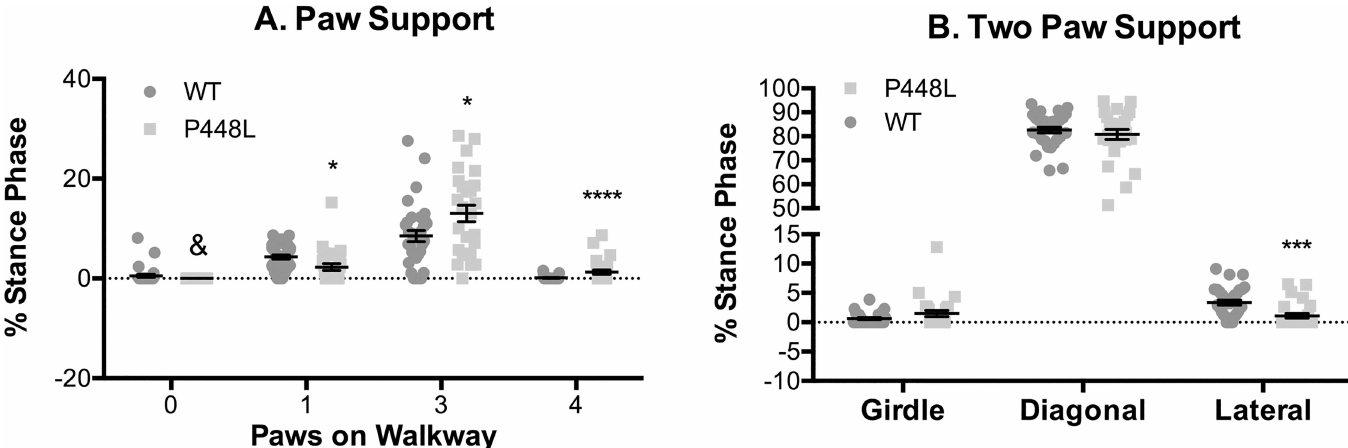
Fig 7. Paw Support. (A) Percentage of rundurationthat no paws, a single paw, threepaws or four paws were simultaneously touchingthe surface. (B) Percentage of rundurationthat two diagonalpaws (RF-LHor LF-RH), contralateral paws (girdle,RF-LFor RH-LH)or lateralpaws (RF-RHor LF-LH)were simultaneously touching.Students t-testwas performed betweenWT and P448L in each group and combined into a single panel.(n = 12; * p < 0.05; ** p (cid:20) 0.01, *** p (cid:20) 0.001, **** p (cid:20) 0.0001 & denotes0 recordedinstances).